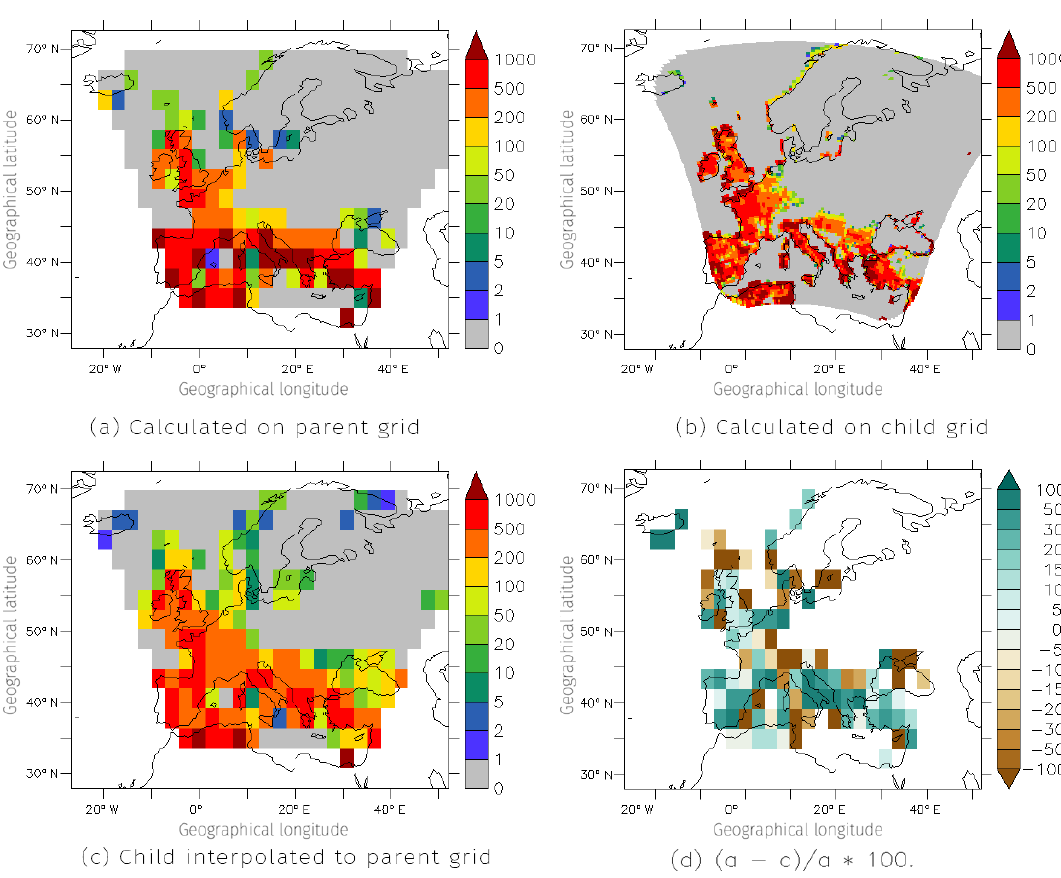
Figure 5. Biogenic NO emissions flux in pgm − 2 s − 1 for one distinct date in January 2003. The data have been masked to show only the coupled